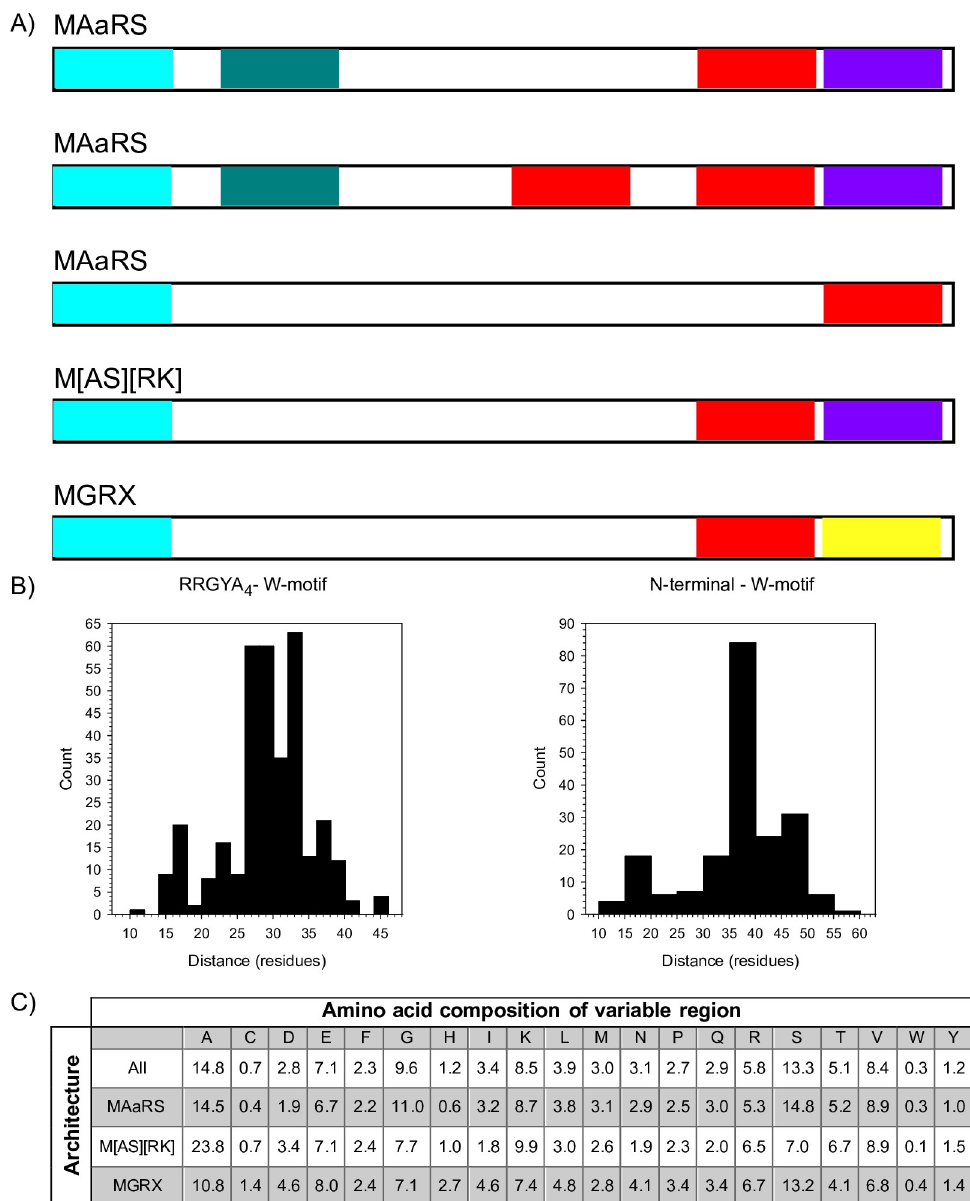
Fig 2. Major architectures of LEA3 proteins. A) Architecture of the LEA3 proteins grouped by the N-terminal motif and by the presence and absence of the C-terminal motifs. N-terminal motifs, light blue; RRGYA 4 motif, teal; W-motif, red; DAELR motif, purple; EDVMP motif, yellow. Bars are not to scale. B) Number of residues between the end of the N- terminal motif or the RRGYA 4 motif and the first W-motif. C) Amino acid composition of the variable region. The column headers show the single letter abbreviation of the amino acids, while the numbers represent the percent of the residues that contain that amino acid. The rows represent the composition in either all LEA3 proteins or by the major